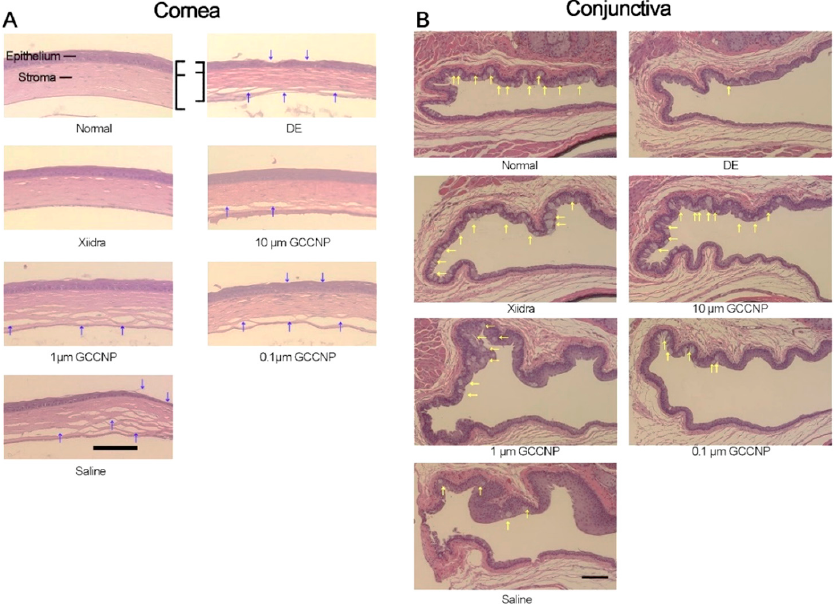
Figure 6. Histological micrographs taken from the cornea and conjunctiva of normal mice, mice with dry eye (DE), and mice that received di ff erent dosages (10, 1, and 0.1 µ M) of CNP-loaded glycol chitosan (GC) nanocarriers (GCCNP) for 7 days. ( A ) Showing the corneal morphology (the blue arrows) and ( B ) exhibiting goblet cells in the conjunctiva (the yellow arrows). Scale bar: 200 µ m. Reproduced with permission from